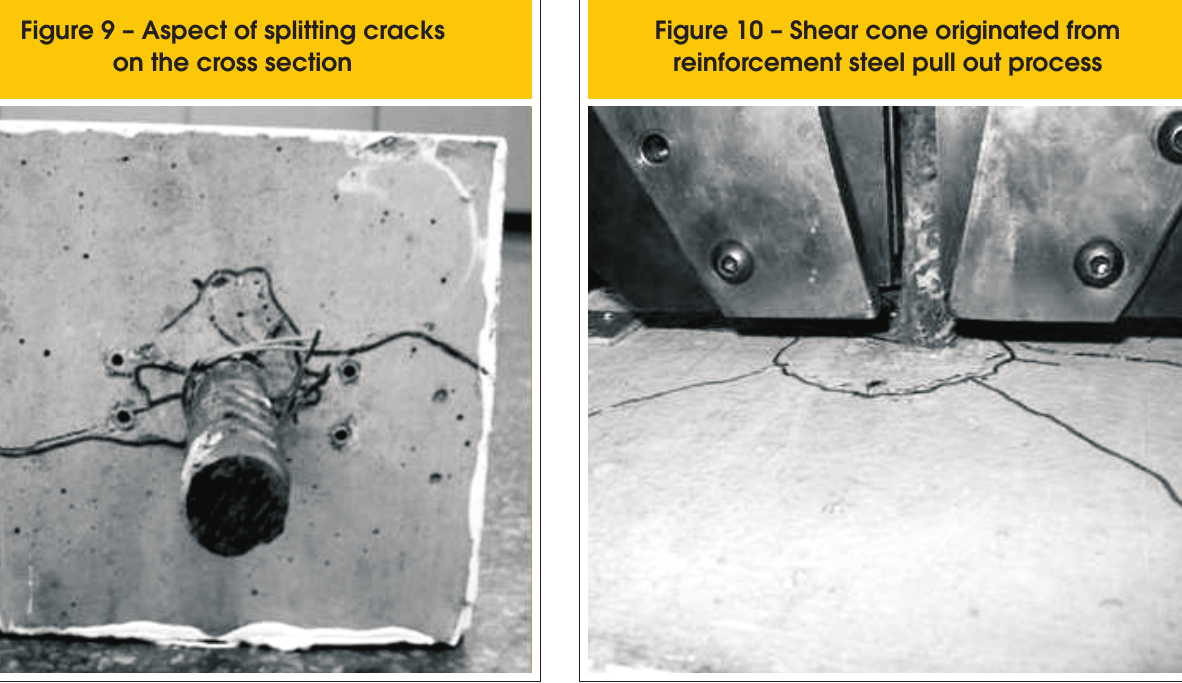
Figure 10 – Shear cone originated from reinforcement steel pull out